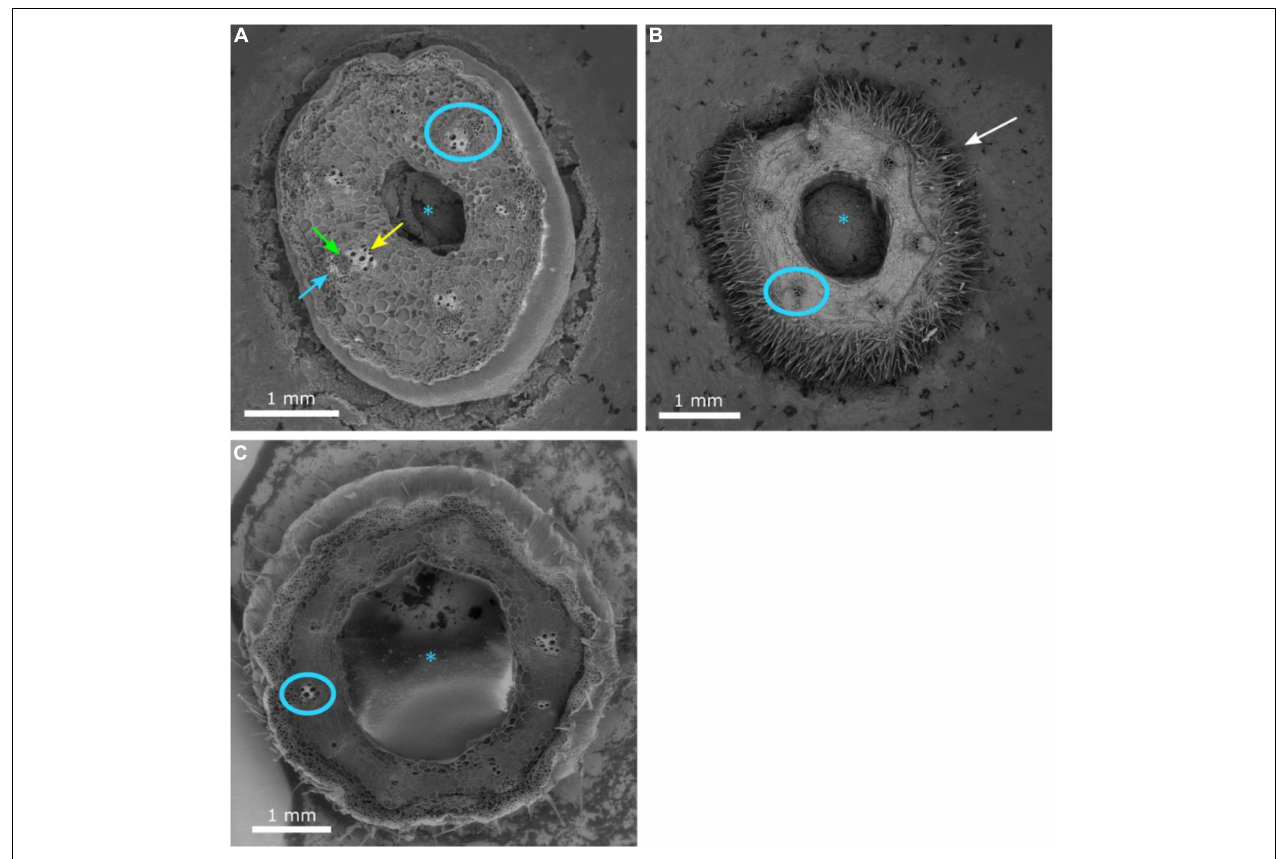
FIGURE 3 | Cross-section of the hypocotyl of non-grafted watermelon cultivar ‘Secretariat’ (A) at 15 days after seeding and rootstocks ‘Pelop’ (B) and ‘Tetsukabuto’ (C) 7 days after seeding. The pith (asterisk), mature vascular bundle (blue circle), xylem (green arrow), internal phloem (yellow arrow), external phloem (blue arrow), and epidermal hairs (white arrow) are